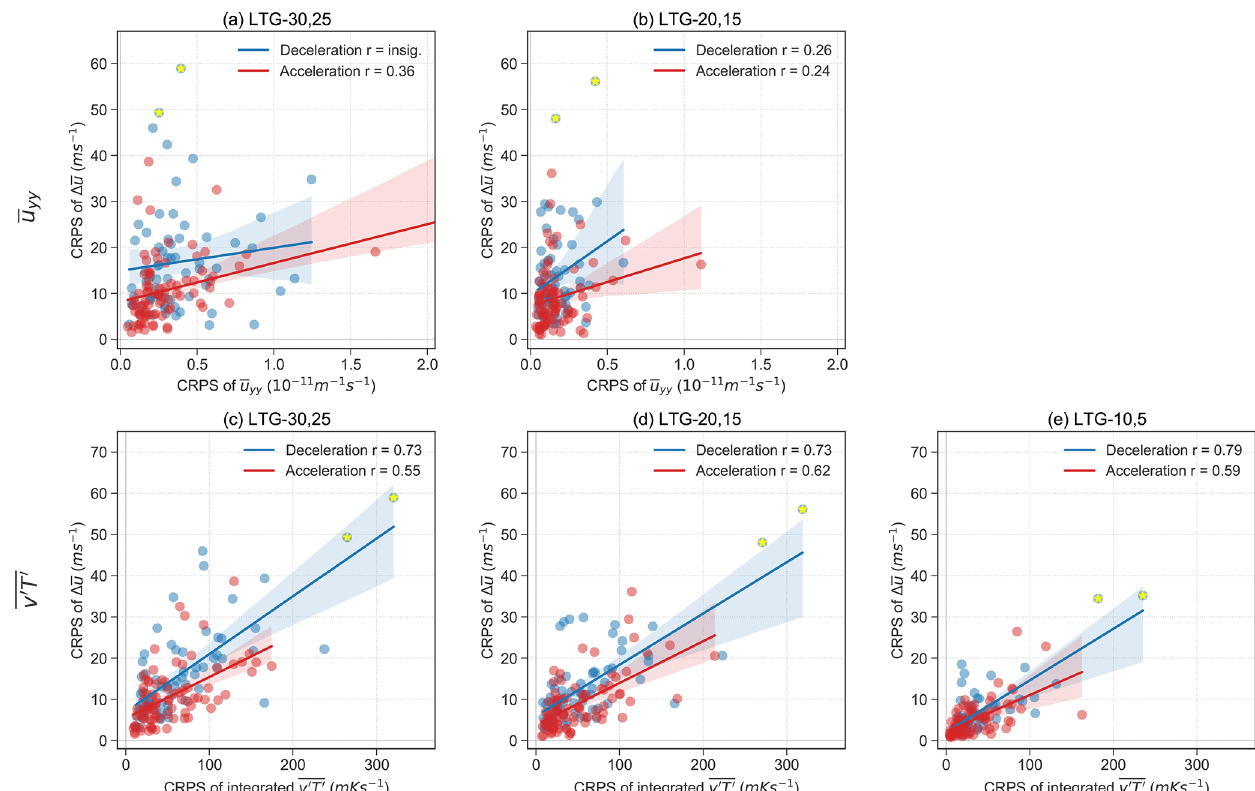
Figure 9. Relationship between the CRPS of (cid:49)u with (a–b) the CRPS of u yy on day − 10 to − 1 and with (c–e) the CRPS of integrated v (cid:48) T (cid:48) over days 0 to 9 for the acceleration (red) and deceleration events (blue) identified from reanalysis. The solid line and the shading correspond to the fitted slope and 95% confidence interval of the fit. The Pearson correlation coefficients ( r ) indicate the correlation in the scatter plots and are statistically significant in all panels at the 95% level. Yellow asterisks (“ ∗ ”) denote the 2009 and 2018 split SSW